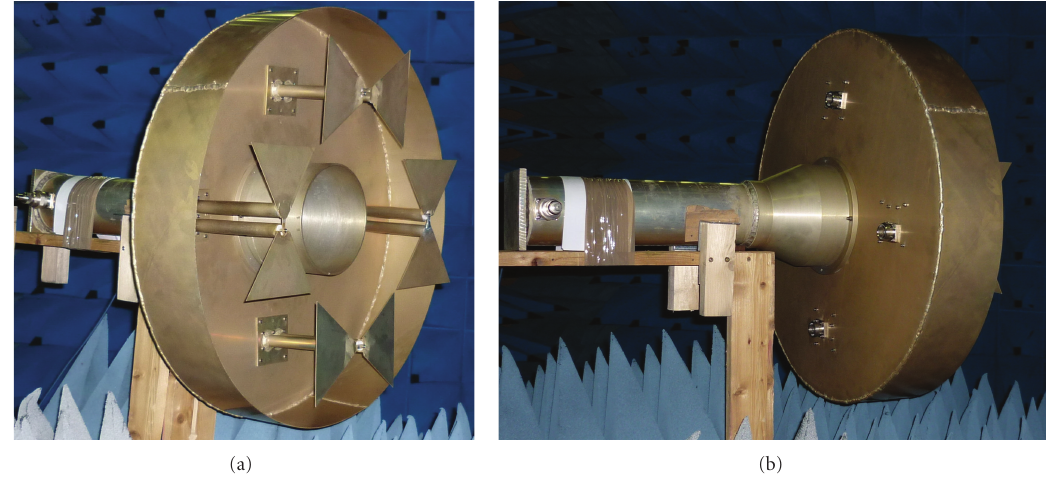
Figure 8: Feed prototype at the ERA anechoic